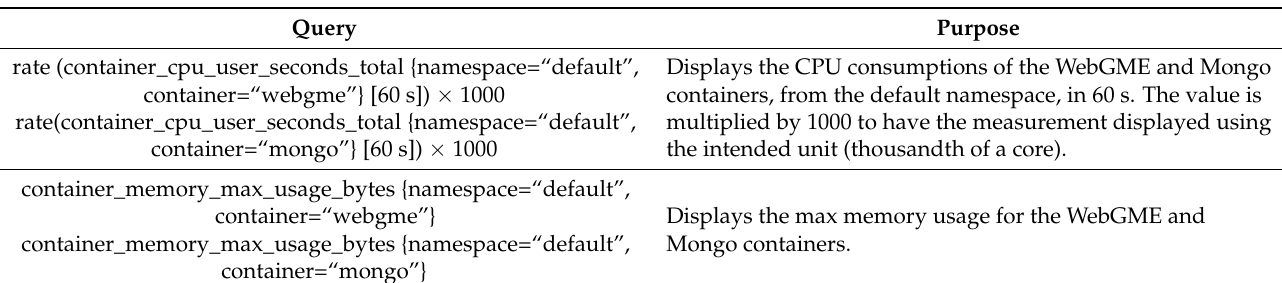
Table 2. Queries for namespace monitoring.